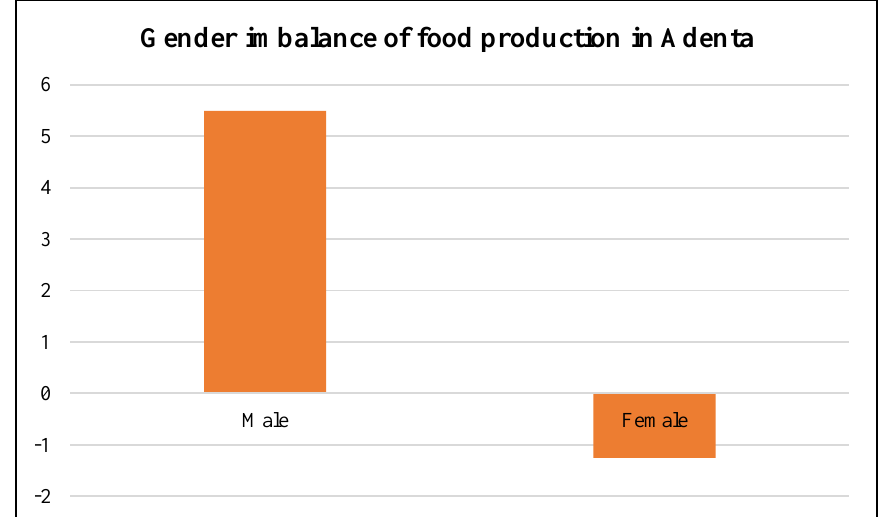
Figure 9. Gender imbalance of food groups in Adenta municipality [48].